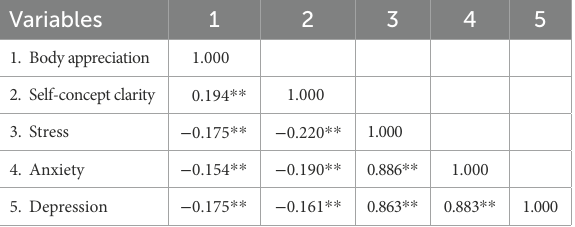
TABLE 2 Correlations of variables.